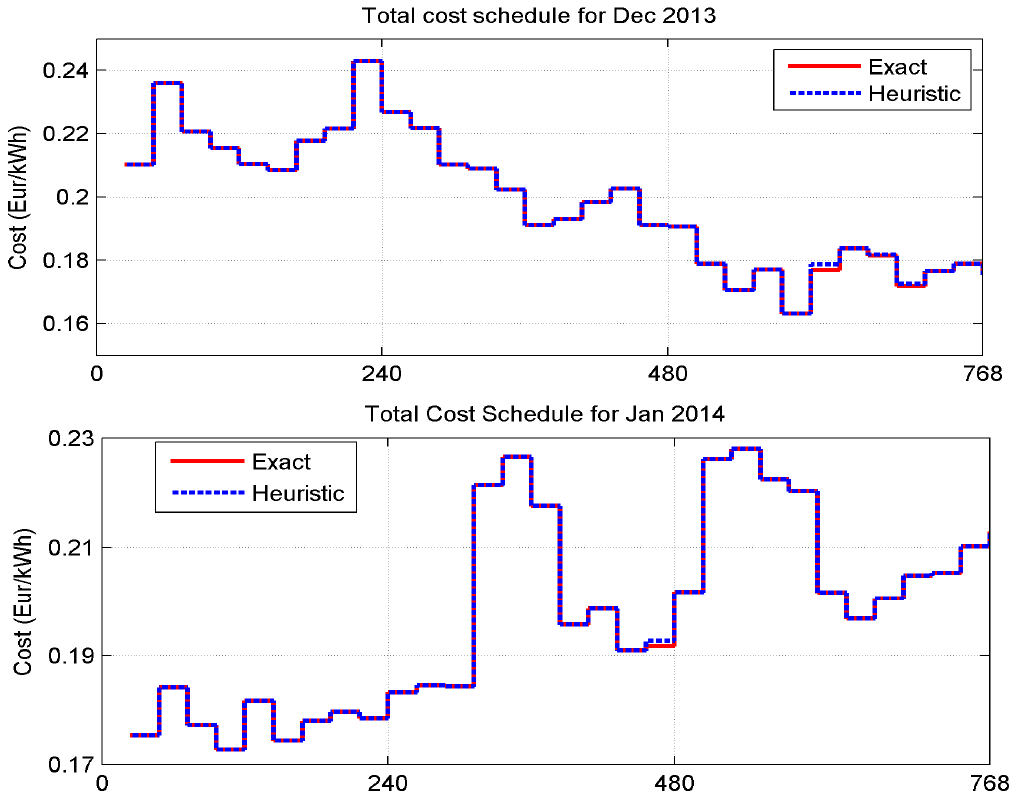
Figure 4. Cont . Figure 4. Cont .